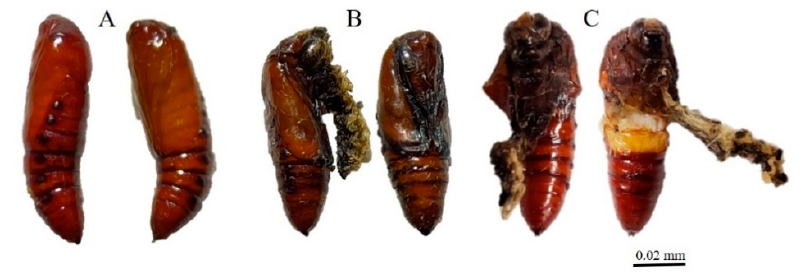
Figure 3 . ( A ) Control 6th instar larvae; ( B , C ) Malformed larvae 6th instar larvae.